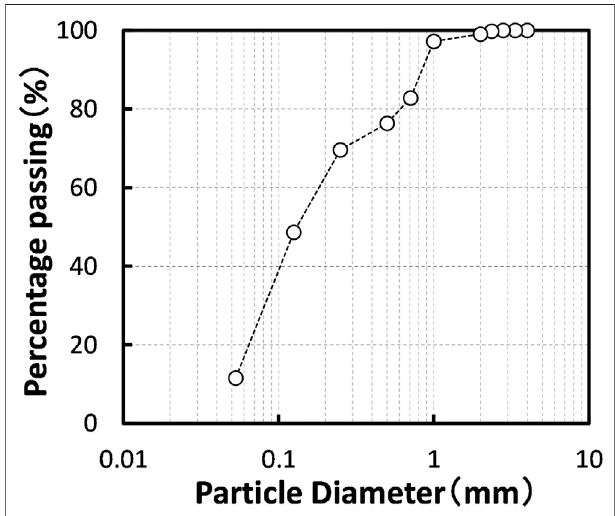
FIGURE 1 | Grain size distribution curve of SSP used in this